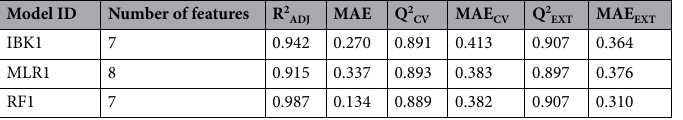
Table 1. R 2 ADJ , Q 2 EXT , Q 2 CV , number of features, and MAE obtained with MLR1, IBK1, and